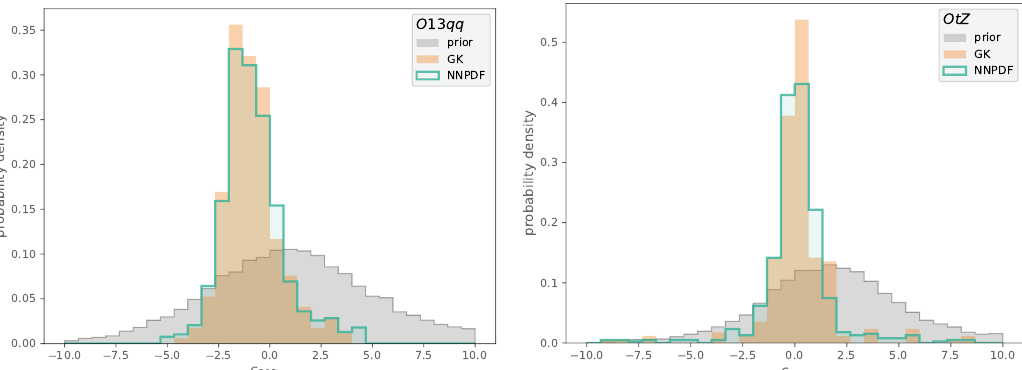
Figure 4.5: Same as Fig. 4.3 now for the case in which only one t -channel single-top dataset added via reweighting as opposed to the complete set of t -channel measurements, see also the results of Fig. 4.4. The NNPDF results correspond to N (cid:39) N eff